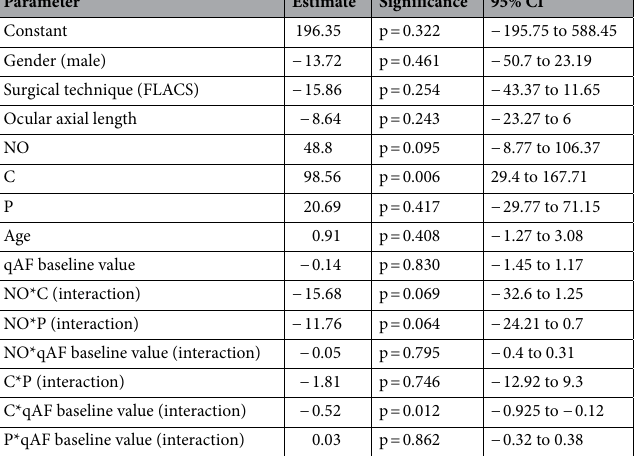
Table 2. Estimates of the fixed effects of the best fitted mixed model with a corrected Akaike information criterion (AICc) of 925.2. Estimates are given for the change in qAF units before and after cataract surgery. CI confidence interval, FLACS femtosecond-laser assisted cataract surgery, NO nuclear opacities, C cortical opacities, P posterior subcapsular opacities, qAF quantitative